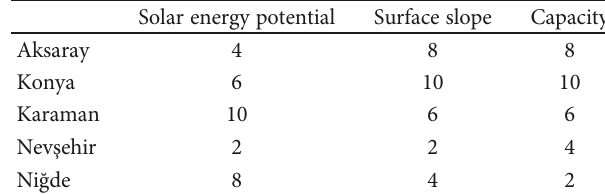
Table 6: Decision matrix.